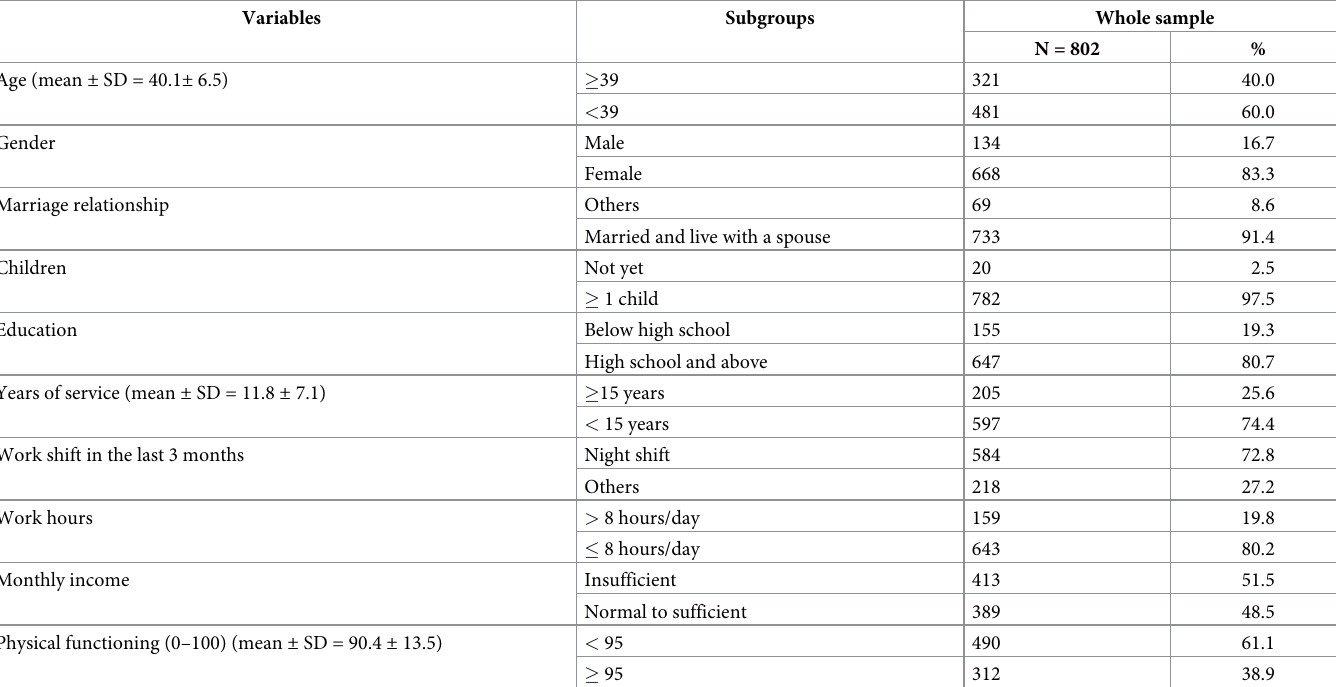
Table 1. Characteristics of study participants (N =